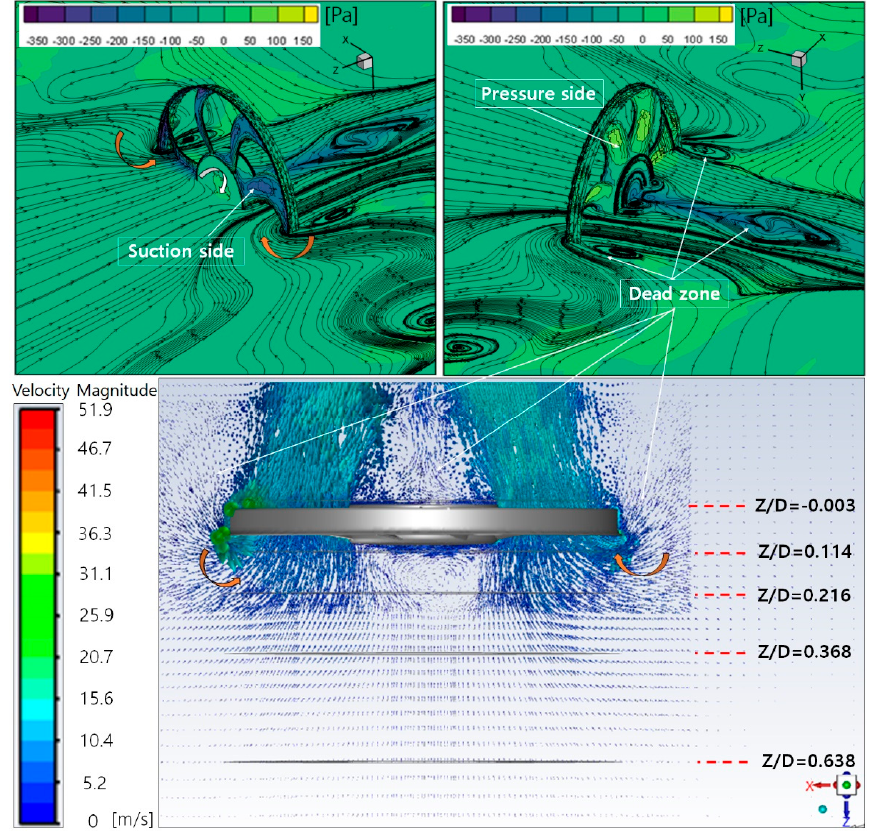
Figure 7. Instantaneous pressure contours on the fan’s surface, and streamlines and velocity vectors in X–Z plane at Z = 0 m (T* = 9.2).